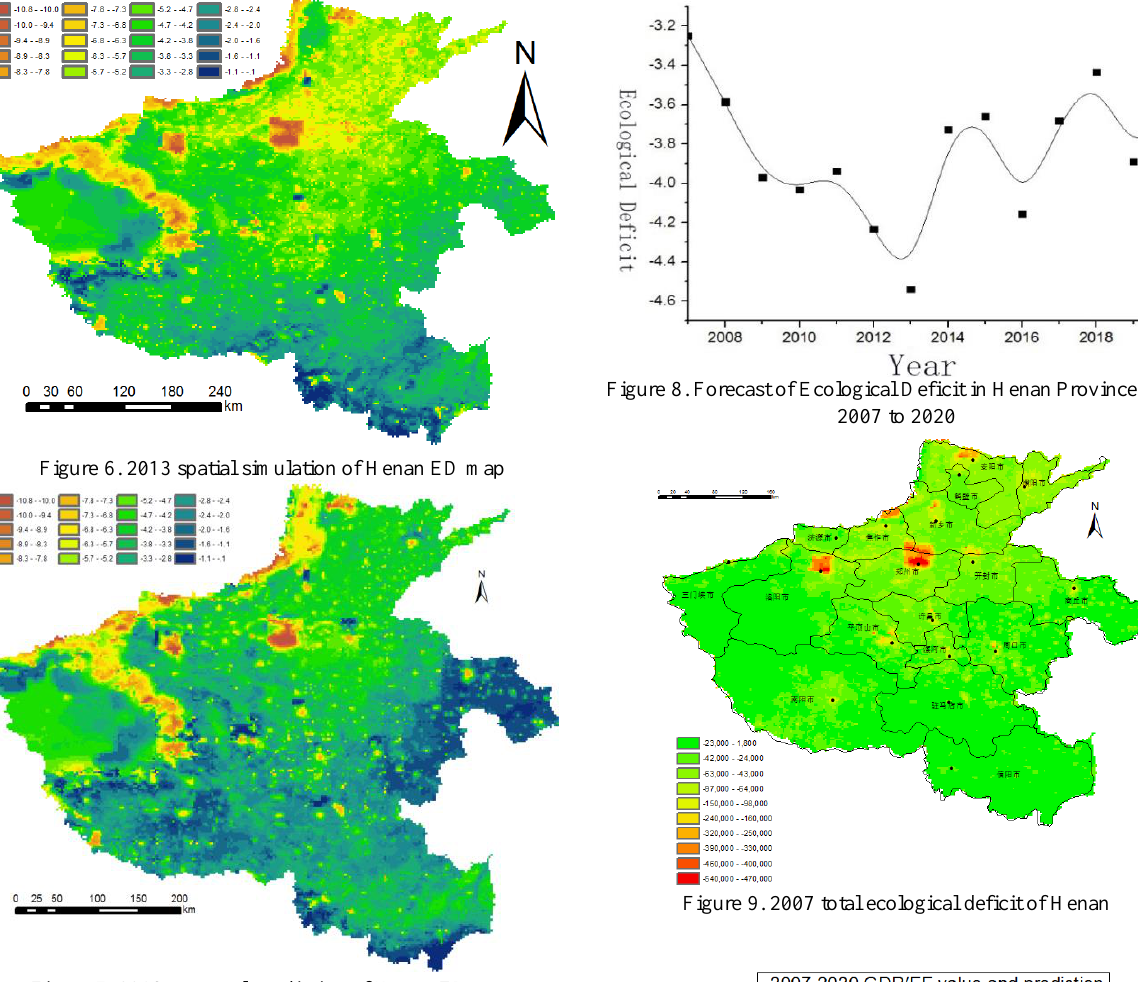
Figure 7. 2018 temporal prediction of Henan ED map